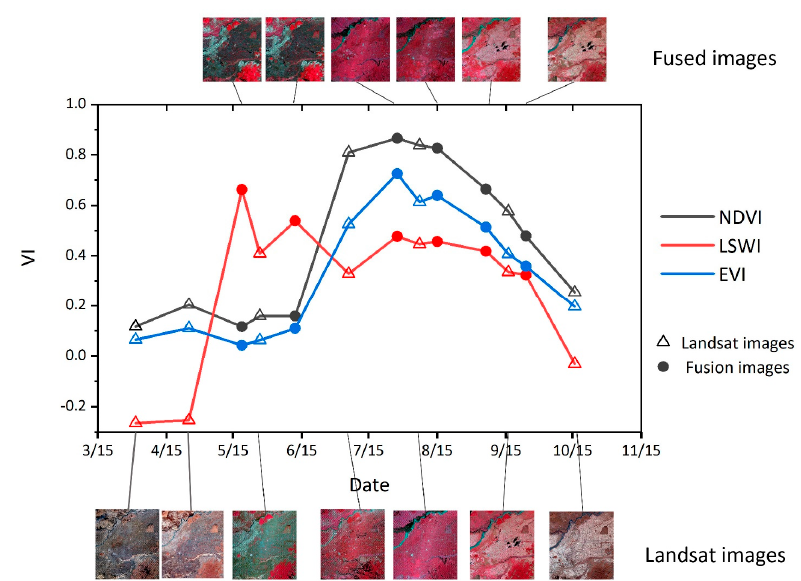
Figure 12. Example of VIs temporal profiles from the fused time series data. The top and bottom rows show the fused images and the real Landsat images from different times used in the study, respectively (site: 132.32°N, 47.31°E).